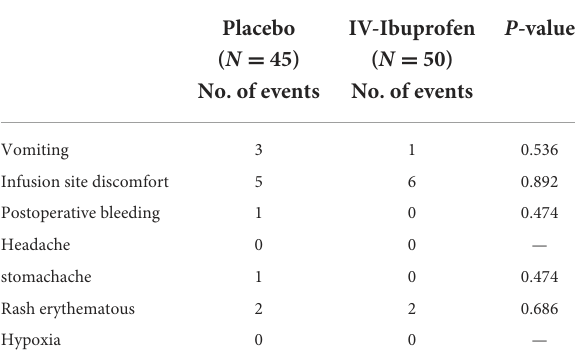
TABLE 3 Adverse